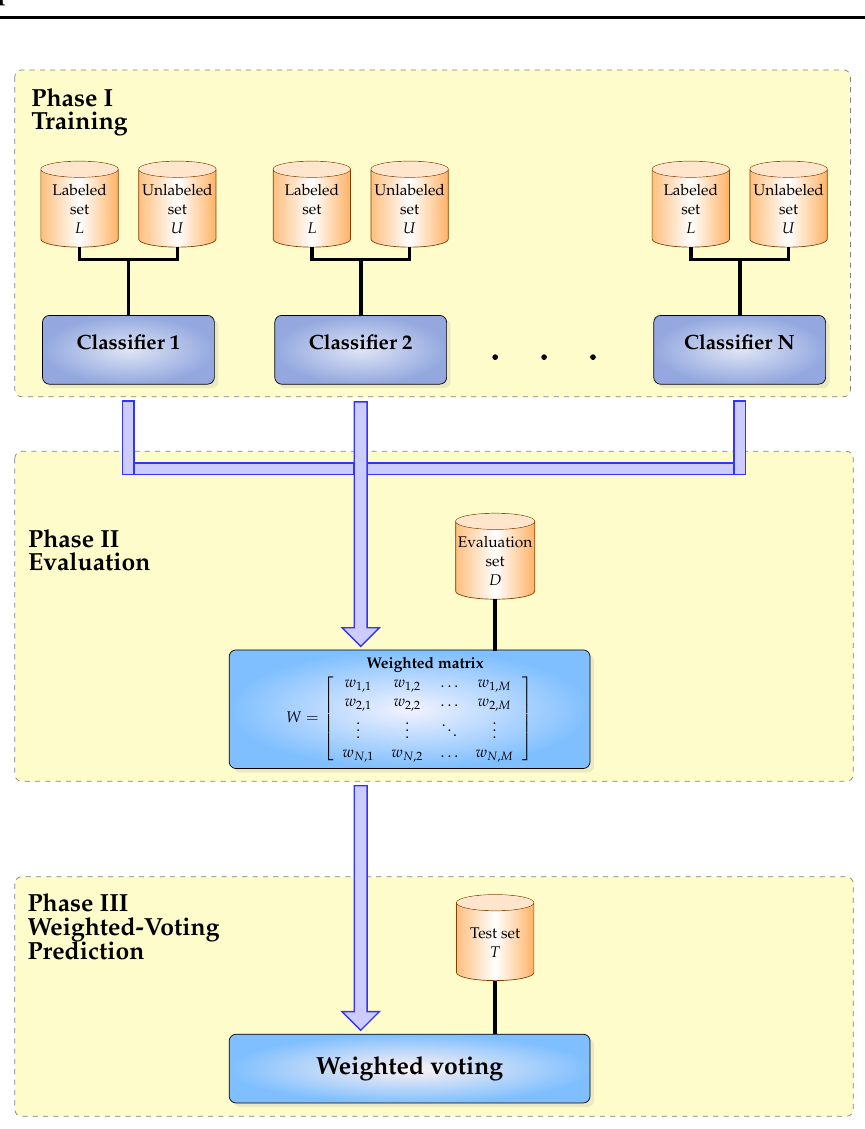
Figure 1. WvEnSL